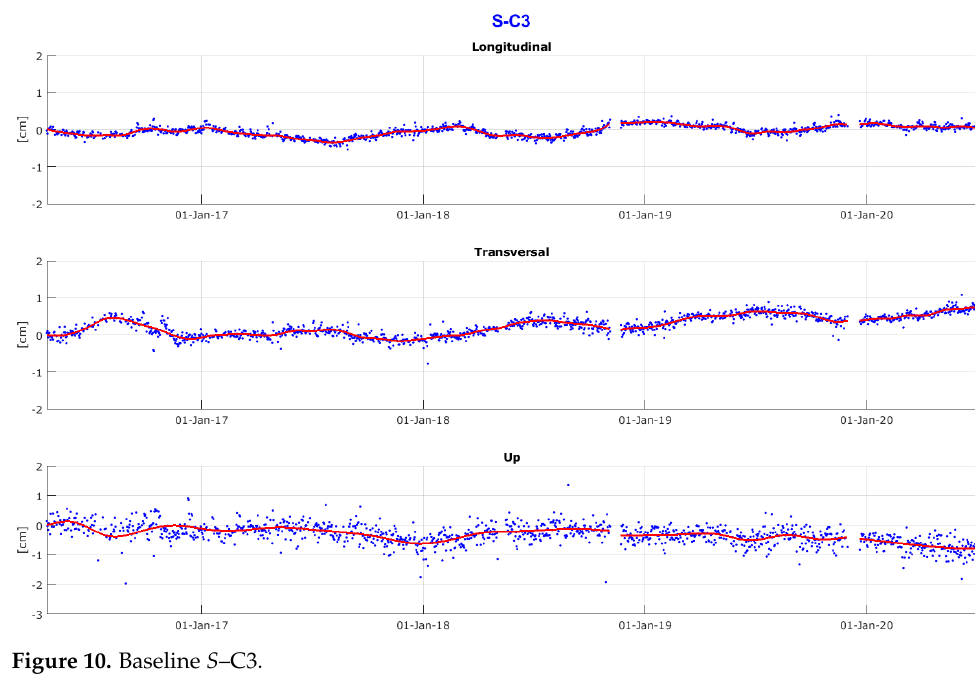
Figure 10. Baseline S –C3.